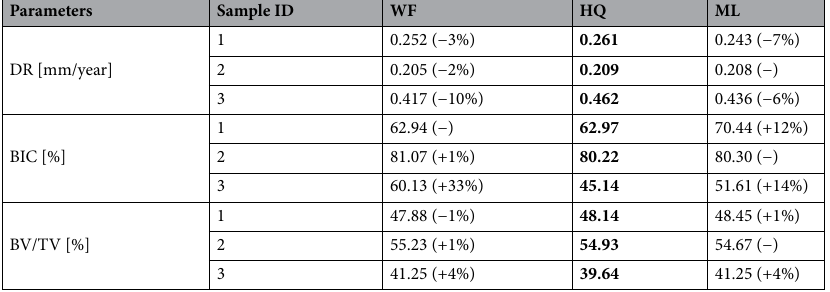
Table 3. Comparison of the quantified parameters for each type of segmentation. We consider high quality (HQ) segmentation as the reference (in bold). Percentage values in brackets represent the relative differences between workflow (WF) and machine learning (ML) segmentation compared to the HQ segmentation. (−) means that the difference was less than